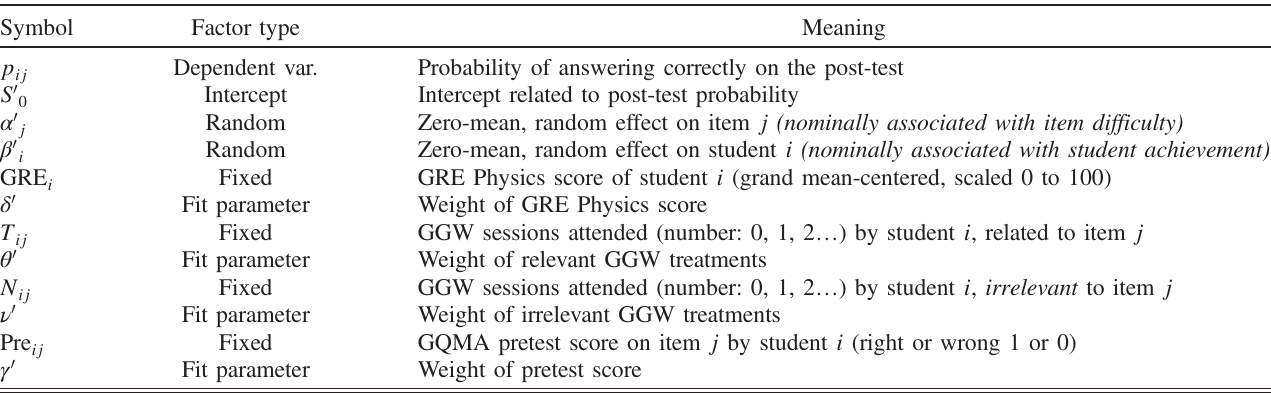
TABLE V. Parameters used in the mixed linear model of student post-test performance on binary-scored GQMA items. Symbol Factor